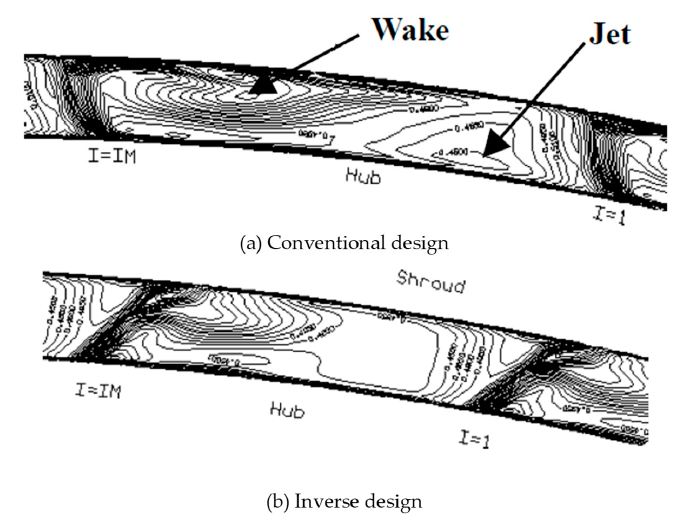
Figure 8. Velocity contour at the impeller trailing edge [10].